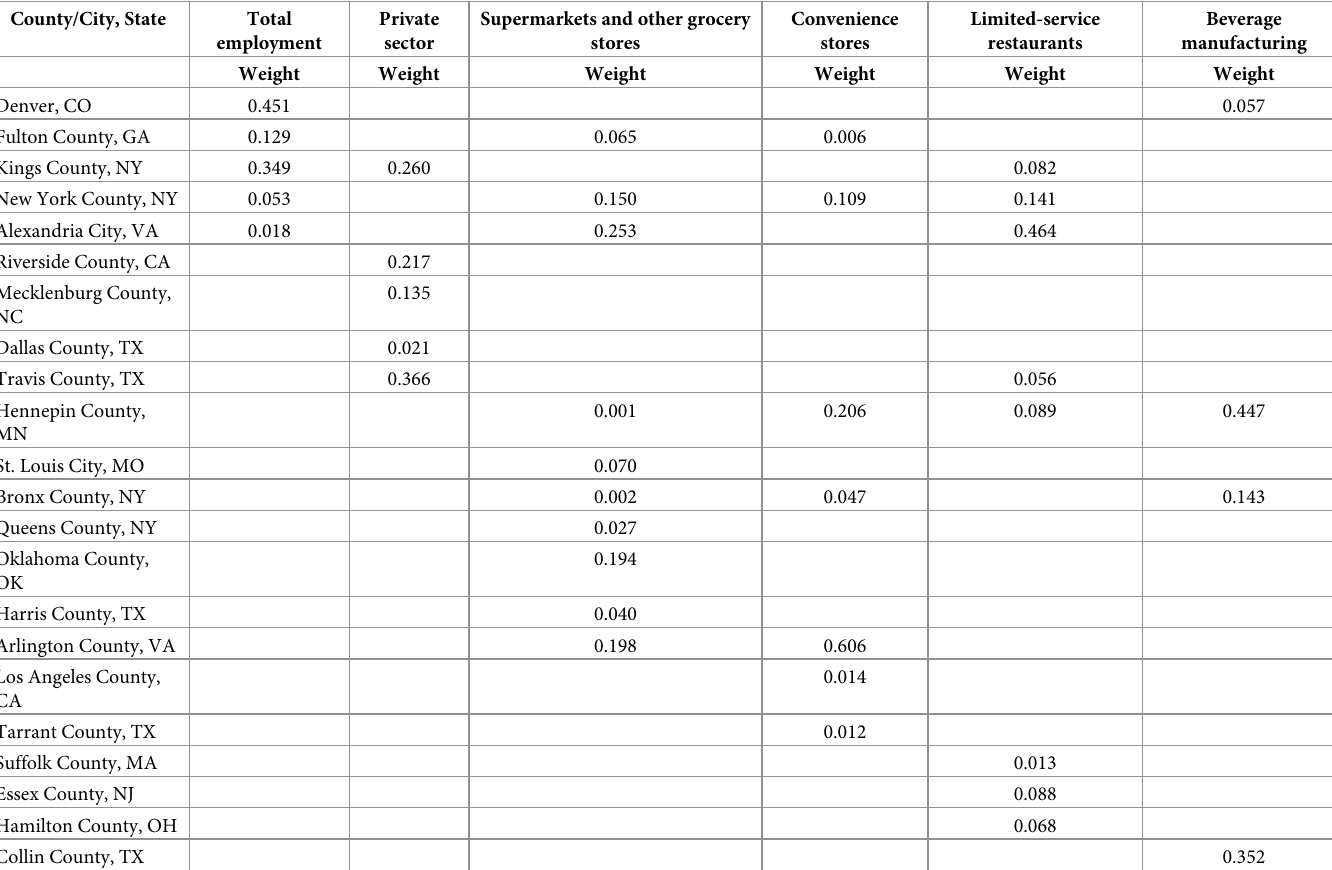
Table 1. Counties or county-equivalent entities with non-zero weights for total, private sector, supermarkets and other grocery stores, convenience store, limited- service restaurant, and beverage manufacturing employment synthetic controls. County/City, State Total Private employment